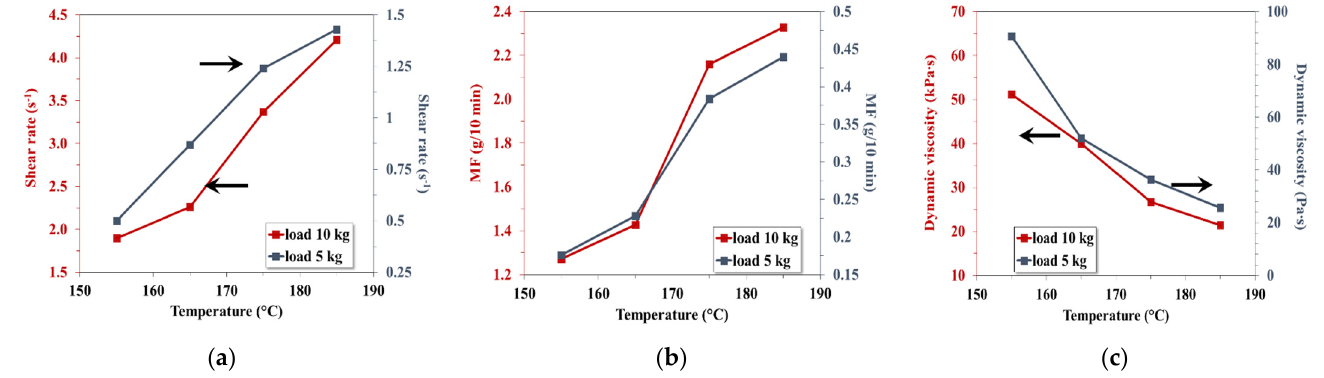
Figure 7. Rheological properties in the melted state of the selected quaternary starch-based blend ( a ) shear rate; ( b ) melt fluidity; ( c ) melt flow resistance.